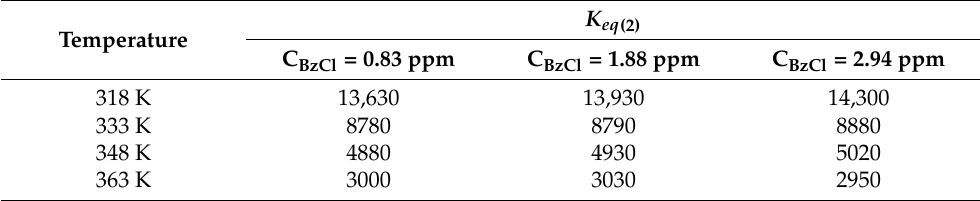
Table 3. Equilibrium constants for Equation (2) calculated from the peak shift in the drift time spectra for different BzCl concentrations in the drift